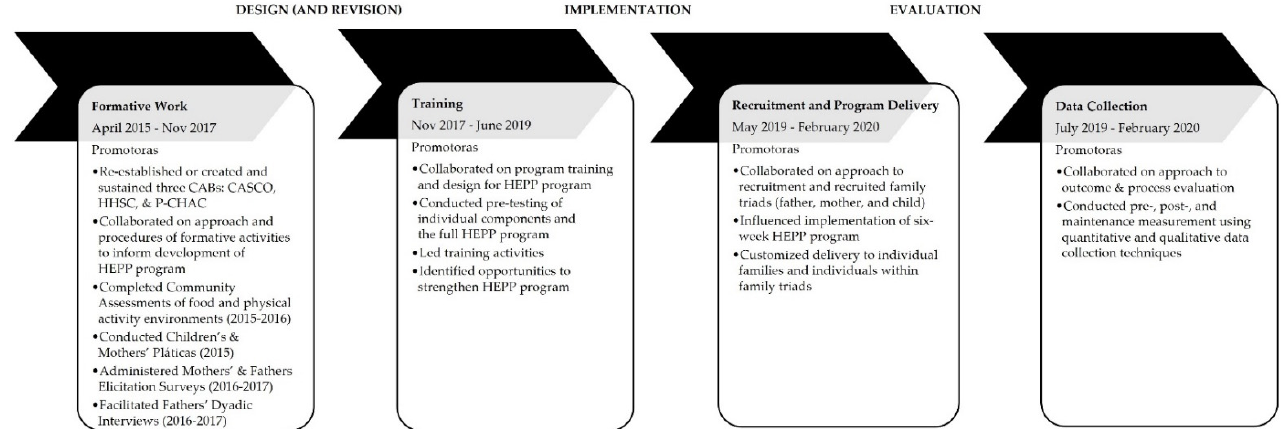
Figure 1. Timeline and promotora engagement throughout the design, implementation, and evalu- ation phases of the HEPP program. This figure shows how promotoras were engaged in different phases of the HEPP program. Due to the COVID-19 pandemic, the program stopped in late February of 2020. Pláticas were a series of group conversations. CAB: community advisory board. CASCO: Advisory Committee for Health and Community. HEPP: Haz Espacio para Papi (Make Room for Daddy). HHSC: Hand-in-Hand in San Carlos). P-CHAC: Progreso Community Health Advisory Council.